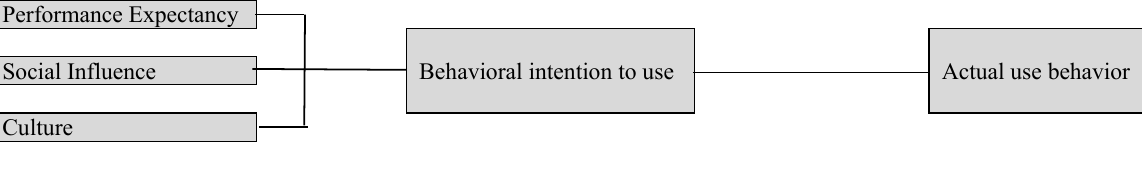
Fig. 3. Modified Conceptual Framework based on